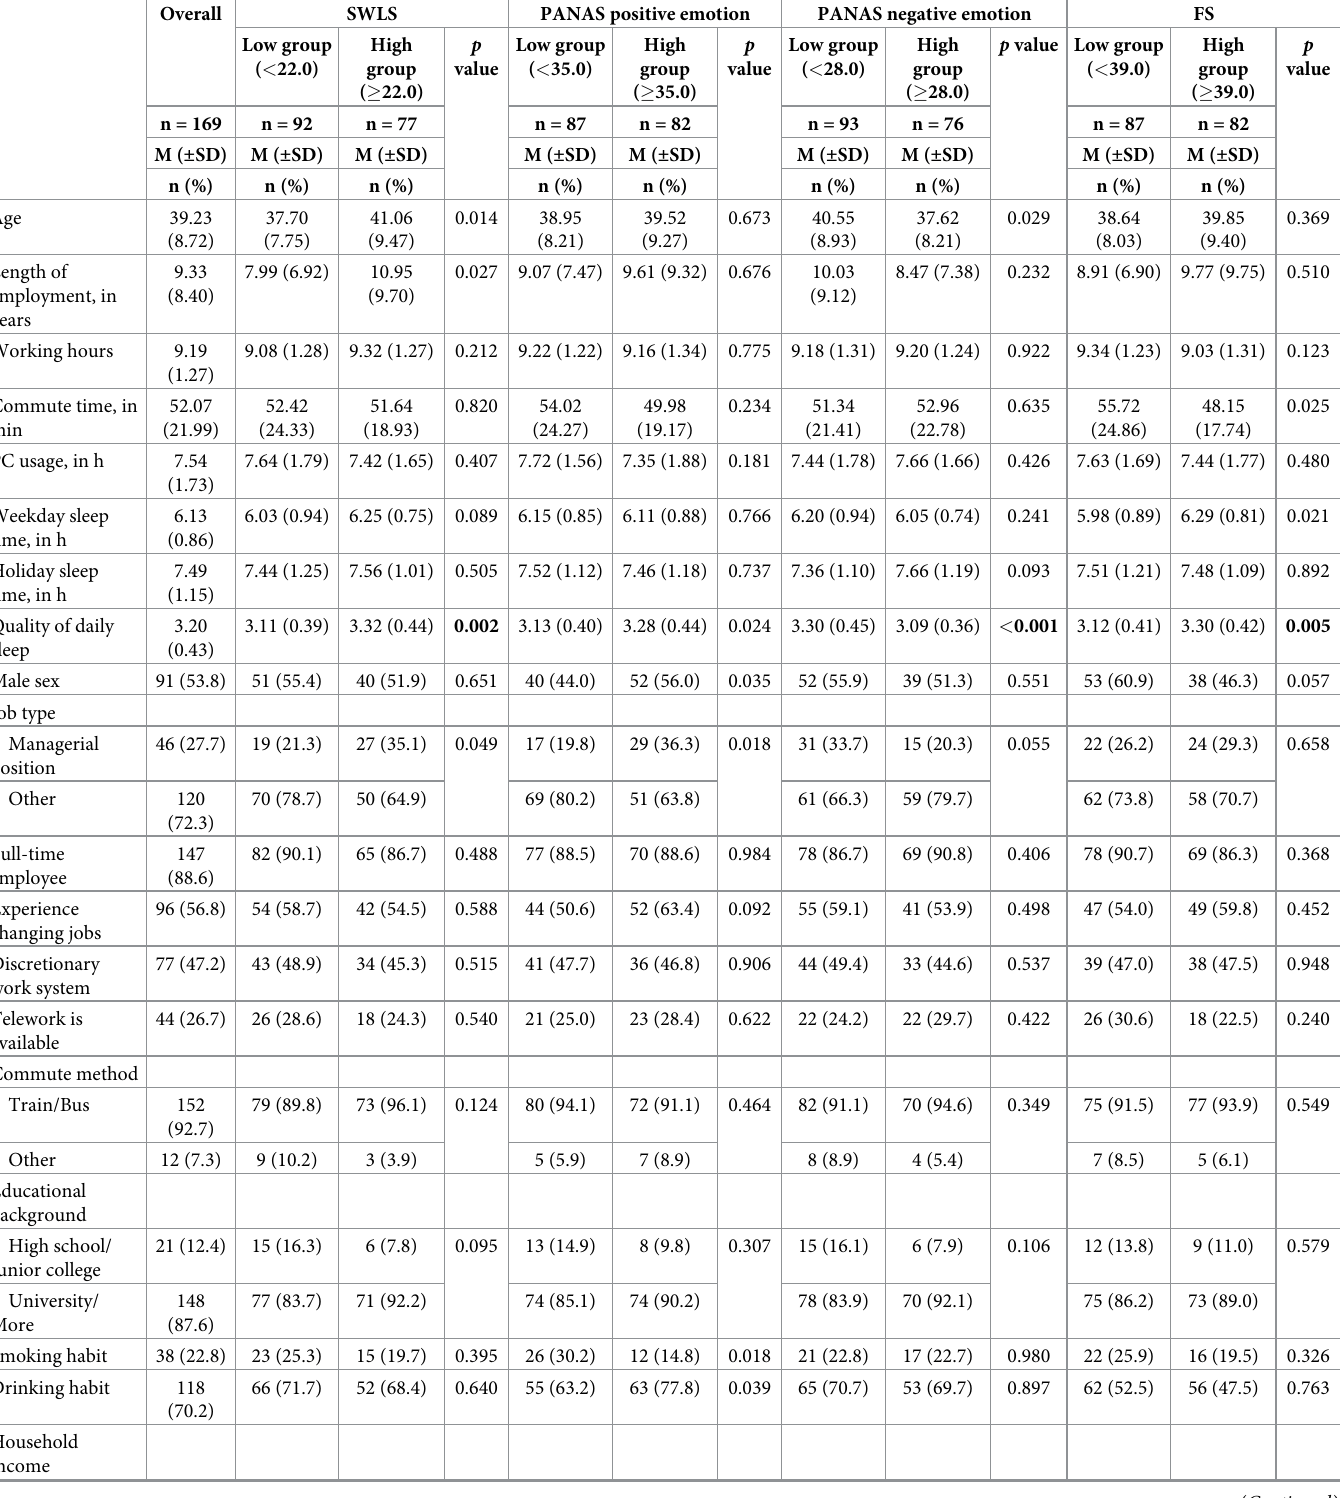
Table 1. Participants’ demographic characteristics and relationship between SWLS, PANAS, FS, and demographic characteristics. Overall SWLS PANAS positive emotion PANAS negative emotion FS Low group ( <